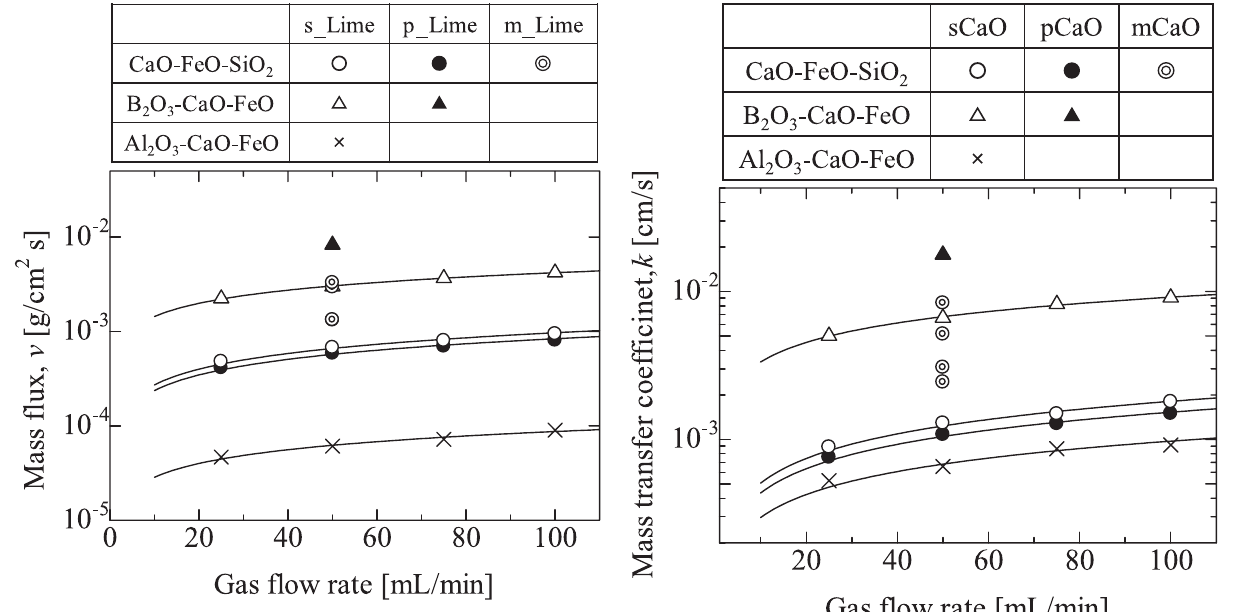
Fig. 17: Mass flux of sintered lime (s-Lime), preheated metallurgical- Lime (p-Lime), and metallurgical lime (m-Lime) into three kinds of slag as a function of gas flow